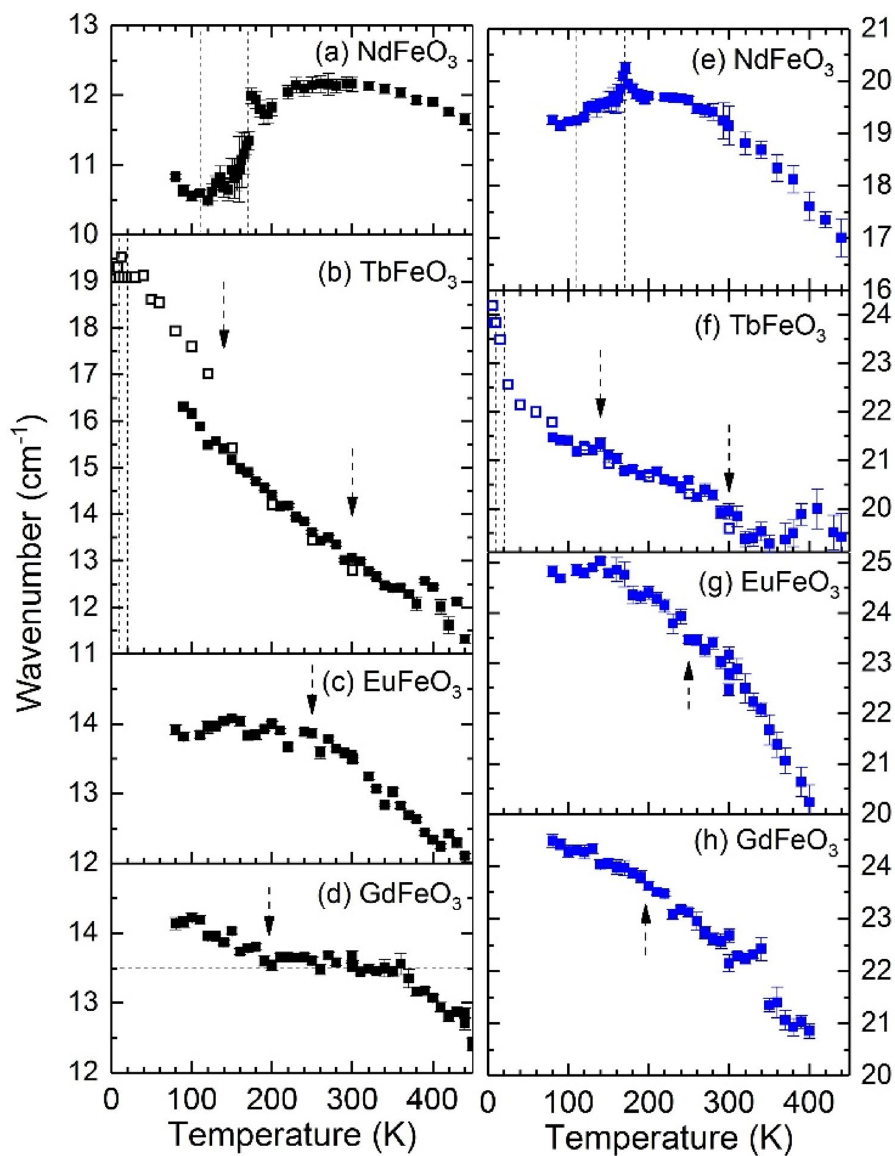
Figure 4. Temperature dependence of the wavenumber of the magnons M1 (left) and M2 (right) observed in NdFeO 3 , TbFeO 3 , EuFeO 3 and GdFeO 3 . Open symbols for TbFeO 3 were taken from Ref. 27 . Vertical dashed lines mark the spin reorientation temperatures following Ref. 13 , while dashed arrows mark relevant M(T) anomalies observed in Fig.